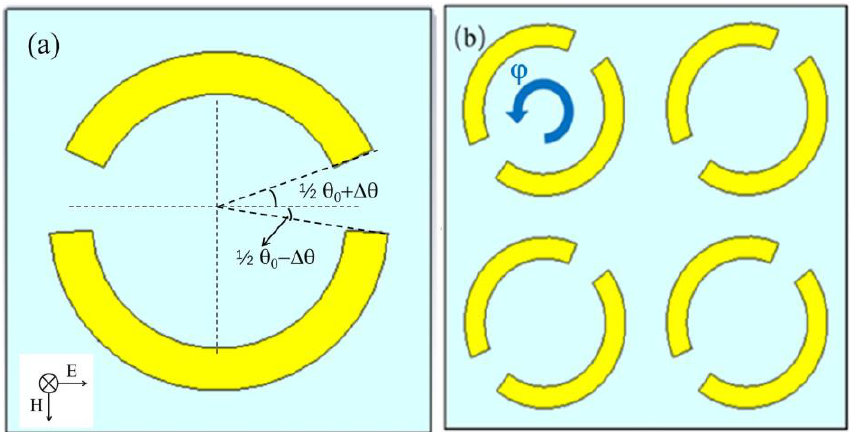
Figure 1. Schematic diagrams of the asymmetric metal ring unit with two openings at a changing angle of Δ θ ( a ) and the asymmetric metal ring array at a rotation angle of φ = 40° ( b ). The THz angle of ∆ θ ( a ) and the asymmetric metal ring array at a rotation angle of ϕ = 40 ◦ ( b ). The THz wave wave TE incidence is indicated in the inset of ( a ). TE incidence is indicated in the inset of ( a